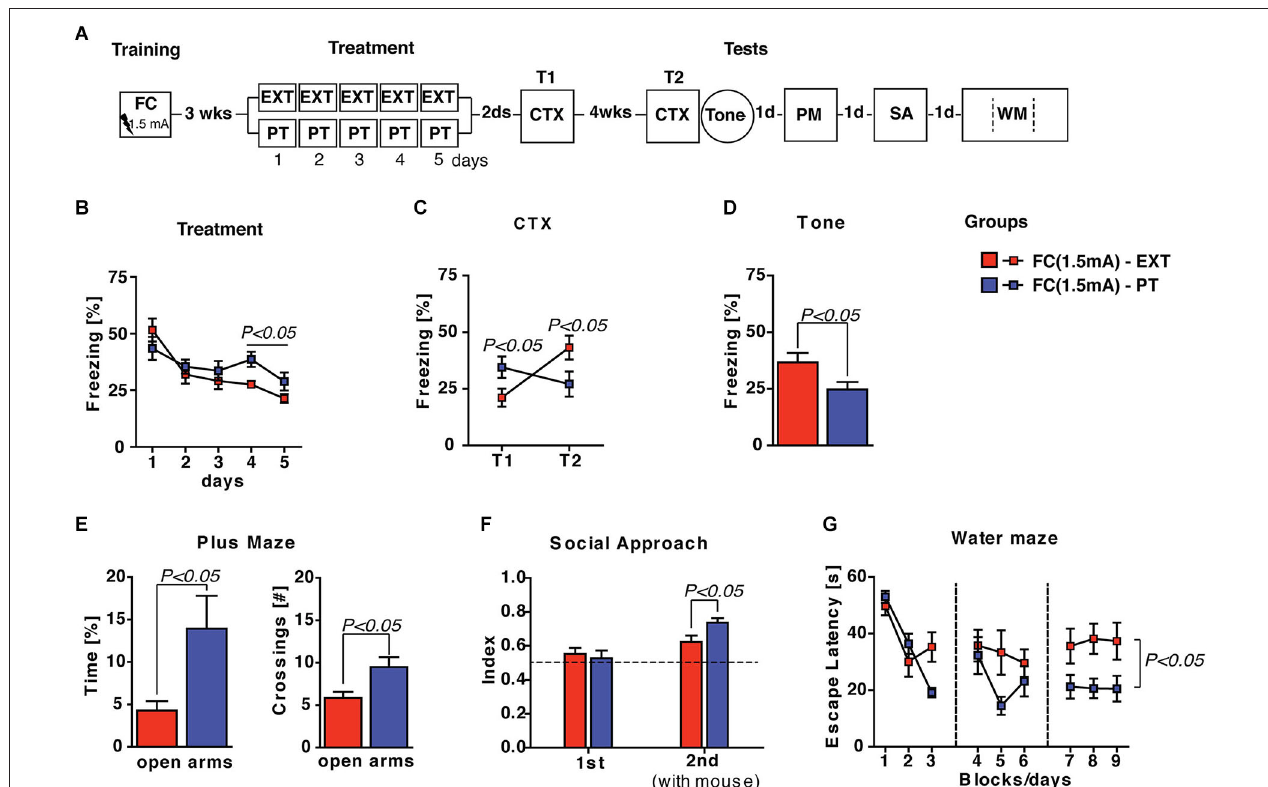
FIGURE 4 | PT treatment is able to restore emotional regulation also after a FC training with a higher footshock (1.5 mA) administration . ( A ) Experimental schedule and groups. FC(1.5 mA)-EXT, mice ( n = 8) underwent 5 days of extinction 3 weeks after fear conditioning employing a higher intensity (1.5 mA) footshock administration; FC(1.5 mA)-PT, mice ( n = 8) underwent to 5 days of PT treatment 3 weeks after fear conditioning employing a higher intensity (1.5 mA) footshock administration. ( B ) Freezing (%) recorded during the 5 days of